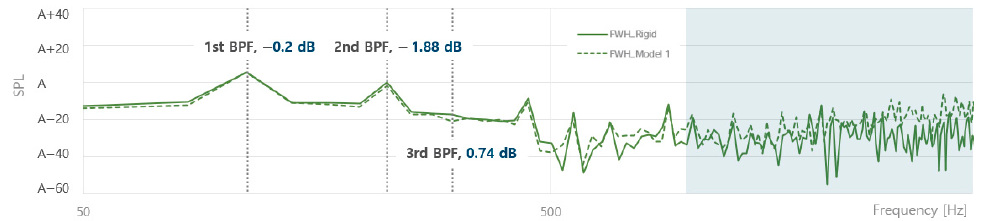
Figure 11. Sound pressure levels of rigid and composite propellers (model 5) in a non-cavitating flow.